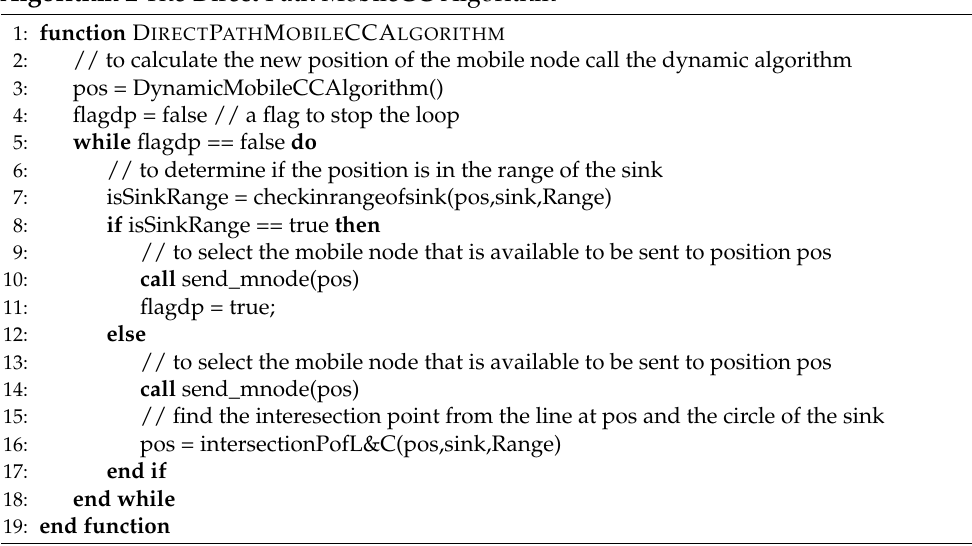
Algorithm 2 The Direct Path MobileCC